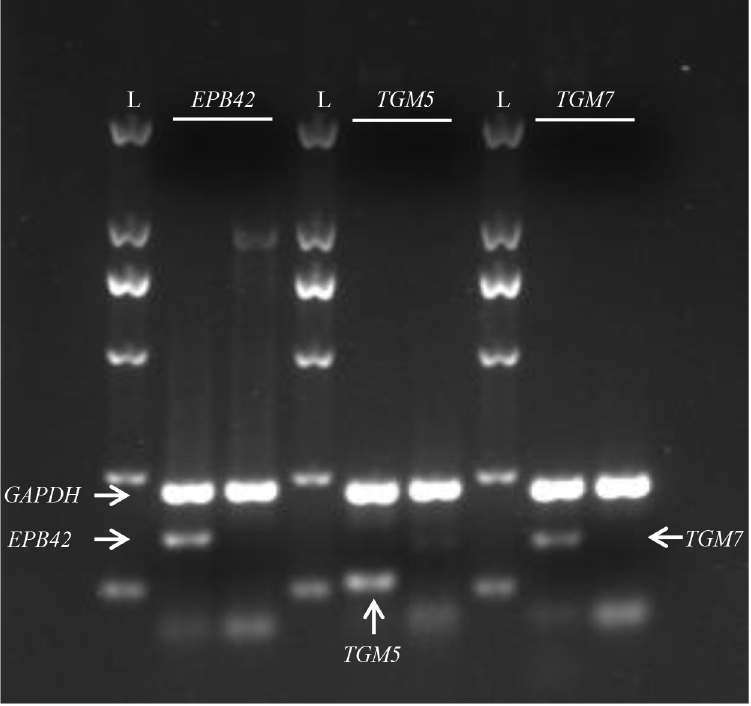
Fig 3. Gene expression analysis (RT-PCR) for EPB42 (left), TGM5 (middle) and TGM7 (right) in Beas-2B cell. For each gene, the left lane is the result from positive control cell line while the right one from Beas-2B. The cell lines K562, HepG2 and SKOV-3 are used as a positive control for EPB42 , TGM5 and TGM7 , respectively. L represents DNA ladder, which includes DNA fragments with known size (from top to bottom, 2000, 1000, 750, 500, 200 and 100 bp). GAPDH (glyceraldehyde-3-phosphate dehydrogenase) is utilized as internal control in PCR. The arrows point out the position of PCR product for different